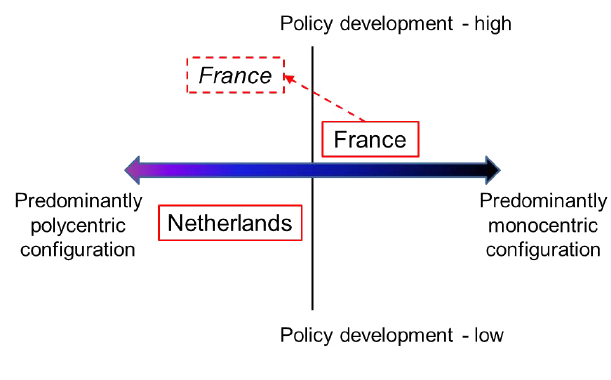
Fig. 2. Overview of the results, with the dashed arrow indicating the evolvement of France’s configuration. On the vertical axis, the advancement of policy development. On the horizontal axis, the contrast between different polycentric configurations, in neither of which the UK fits, thus left